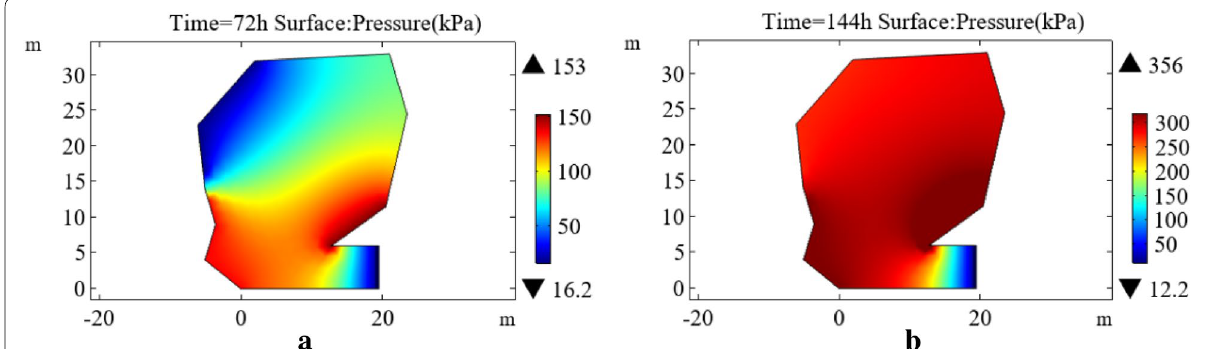
Fig. 13 Stress distribution in the test stope at the filling time of 3 days ( a ) and 6 days ( b ).